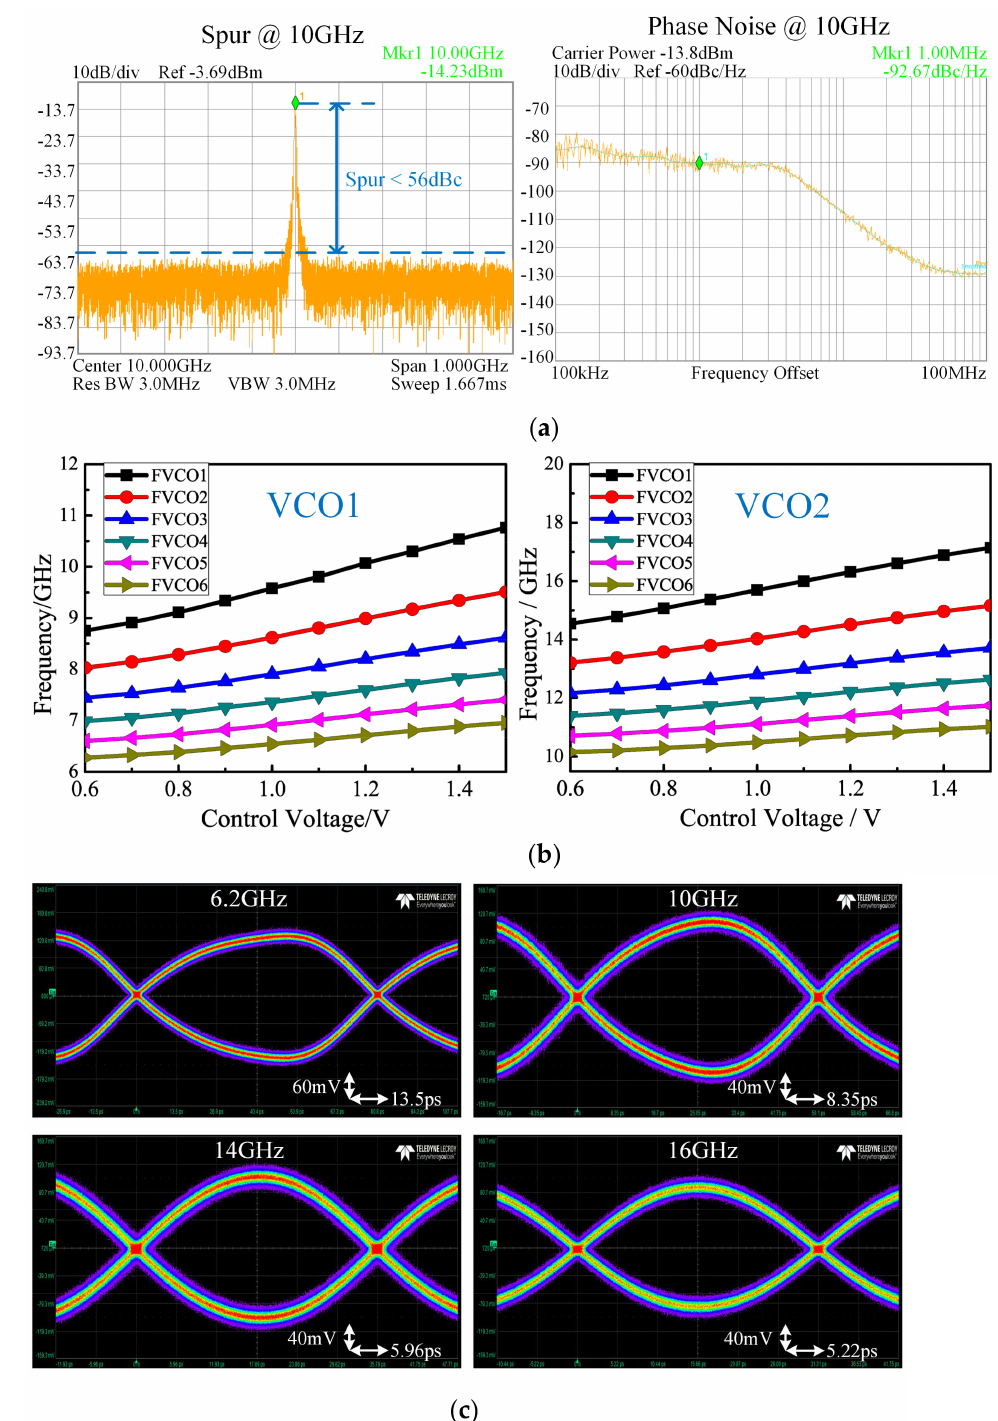
Figure 8. ( a ) Measured spur and phase noise of the designed PLL at 10GHz; ( b ) Measured frequency range of VCO1 and VCO2; ( c ) Measured PLL output eye diagrams at 6.2/10/14/16